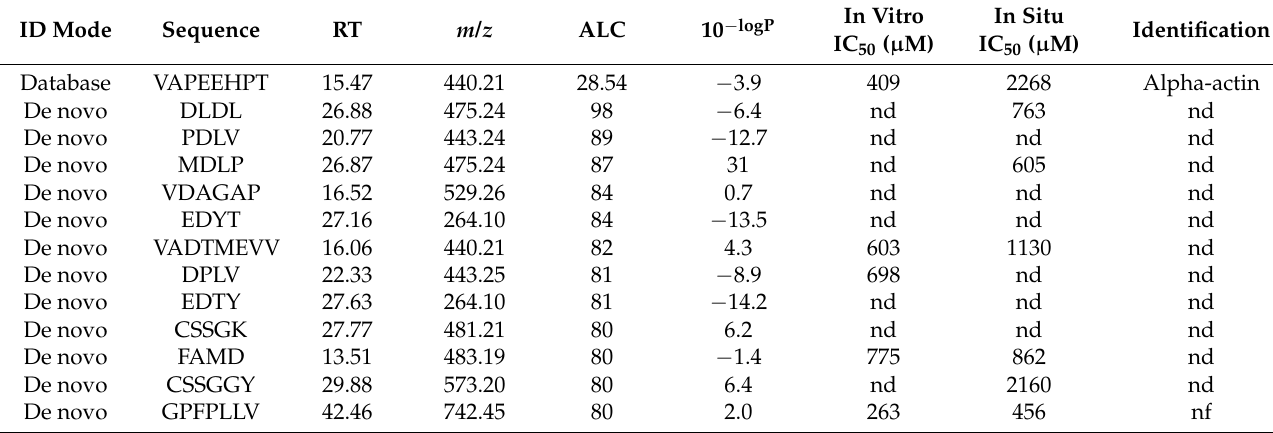
Table 2. In vitro and in situ DPP-IV inhibitory activity of the 13selected-chemically synthesized peptides following their identification by database confrontation or de novo sequencing (ID mode). Peptides were listed according to their RP- UPLC-MS/MS characteristics (retention time (RT) and mass to charge ratio ( m / z ) and their identification score displayed (i) by the average local confidence (ALC) score for the de novo sequencing, (ii) by the − 10 logP score for database confrontation with the mass error (in ppm) for both identification modes. Values of the in vitro and in situ DPP-IV inhibitory activity (IC 50 ) were determined by linear regression correlating the DPP-IV activity inhibition percentage and the Ln of the peptide concentration. nd: when the identification of the parent protein was not possible and when the IC 50 value was above 2500 µ M or undeterminable.